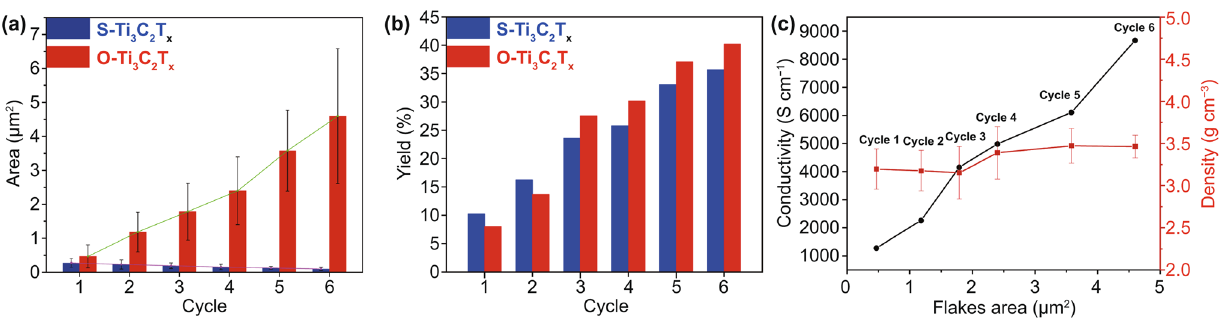
Fig. 3 Comparison of a average flakes area and b yield at different cycles between S-Ti 3 C 2 T x and O-Ti 3 C 2 T x . c Conductivity (black) and density (red) of O-Ti